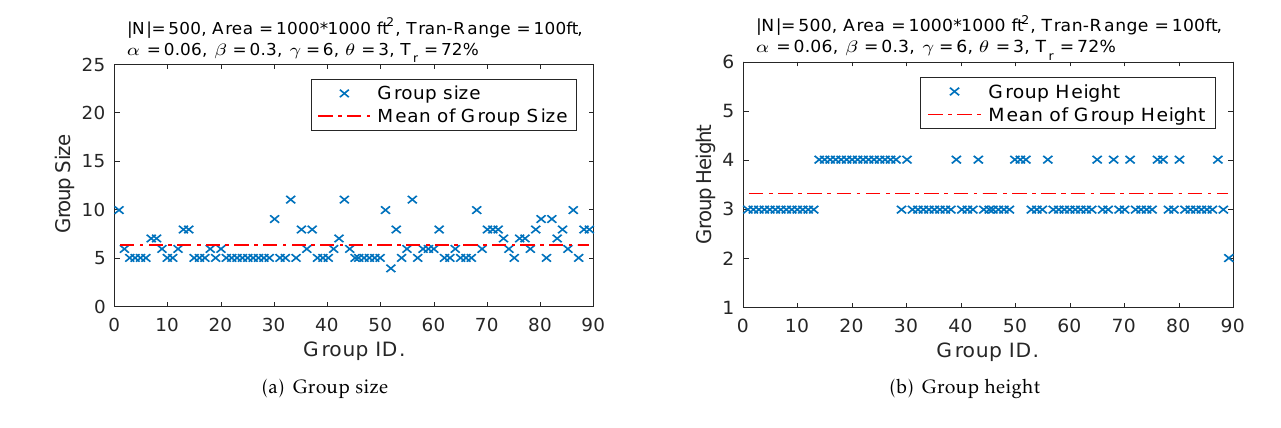
Figure 4. Grouping